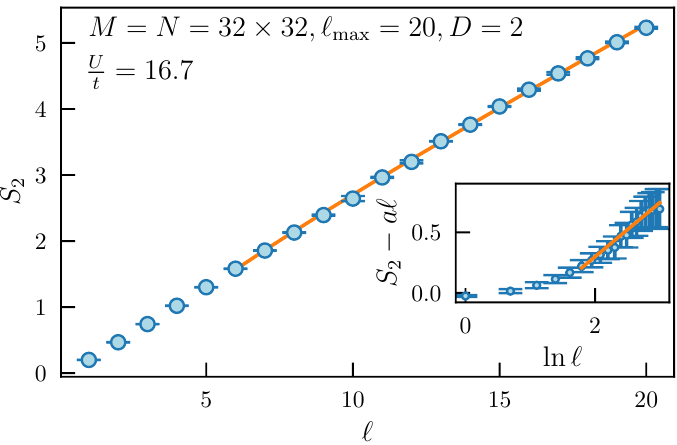
Figure 11: Finite-size scaling of the second Rényi Entropy in a square lattice of size M = 32 × 32 at unit-filling for various subregion sizes. The subregions are made up of lattice sites arranged as squares of linear sizes ℓ = 1,2,...,20. The entanglement is seen to increase linearly with the boundary of the subregion. The data is fit to a linear model with a sub-leading correction term that is logarithmic in ℓ , as shown in Eq. (55), yielding a ≈ 0.2, b ≈ 0.5, and c ≈ − 0.6. The interaction strength was fixed to a value near the 2 D critical point. The inset shows a plot of S minus the 2